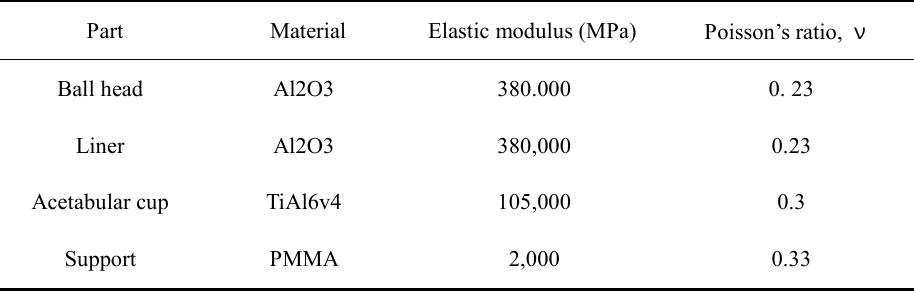
Table 2. Material properties used in acetabular cup FE